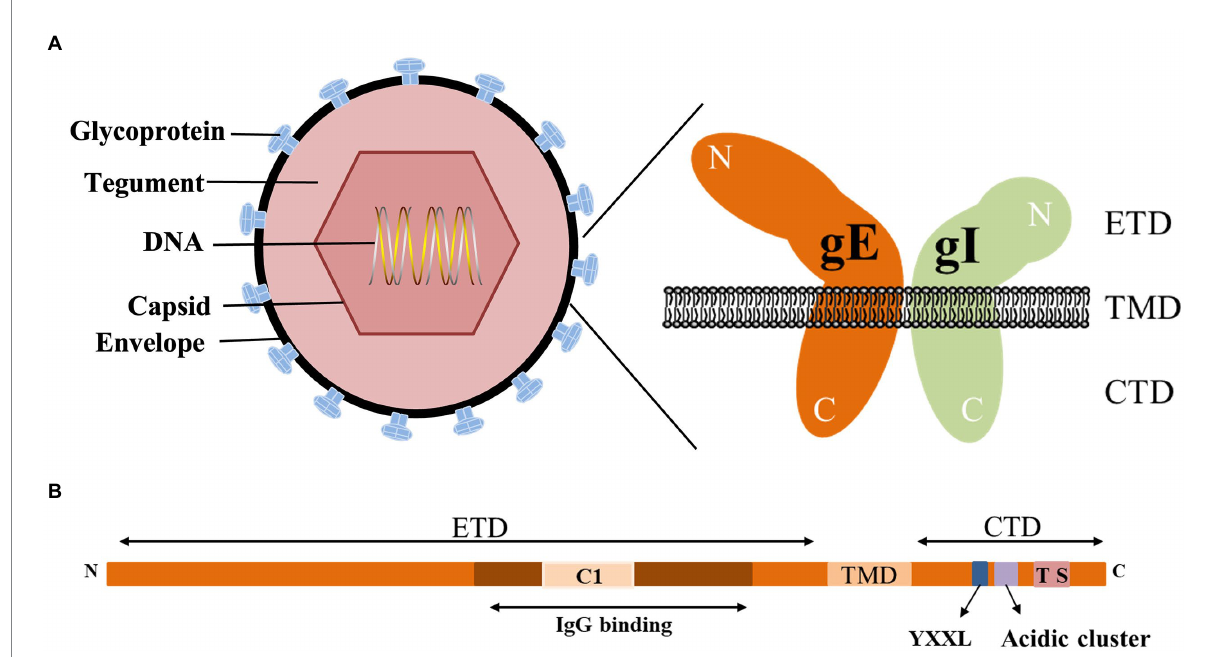
FIGURE 1 Structure of the alphaherpesvirus gE. (A) Structure of alphaherpesviruses and gE/gI heterodimer (DuRaine et al., 2017). (B) Main features of gE identified in this paper (Polcicova et al., 2005; Farnsworth and Johnson, 2006; Sprague et al.,